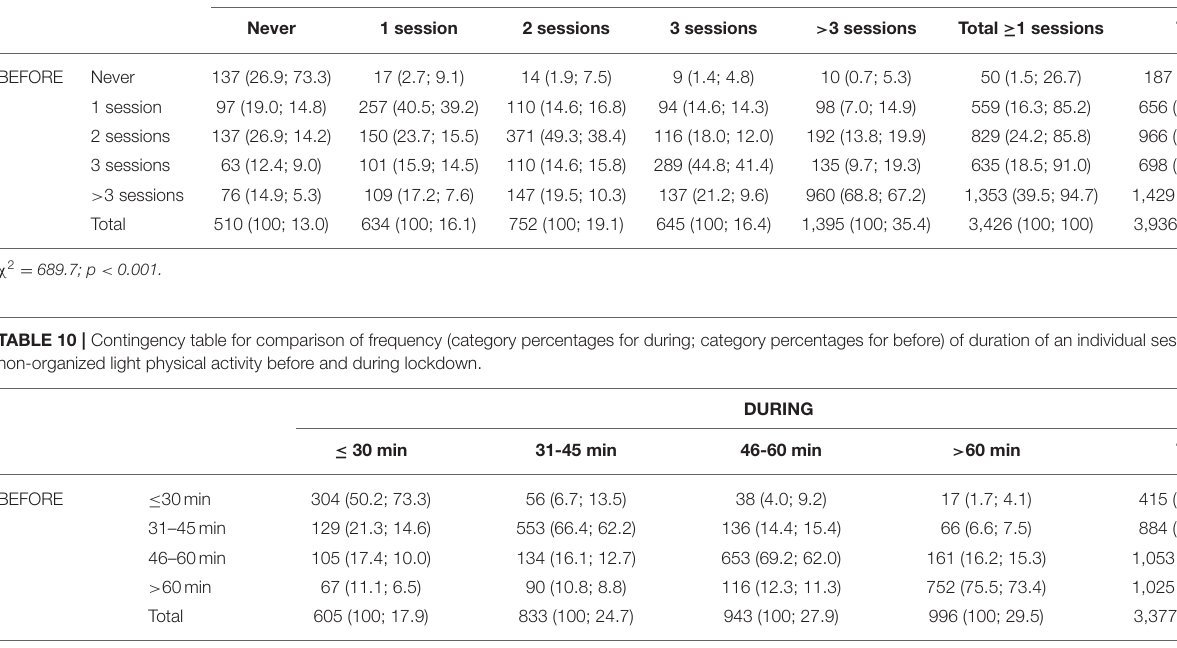
TABLE 9 | Contingency table for comparison of frequency (category percentages for during; category percentages for before) of participation in non-organized light physical activity before and during lockdown. DURING Never 1 session